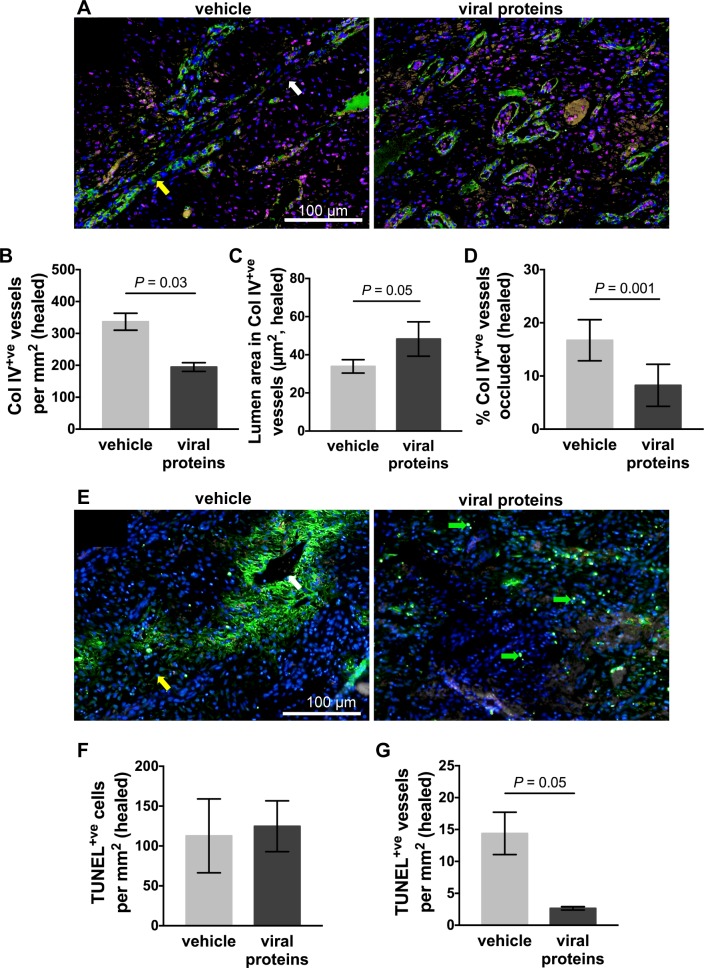
Blood vessel integrity in healed limb wounds of horses following treatment with viral proteins.(A) Representative photos of healed wounds stained with DAPI (blue) and antibodies against blood vessel endothelial cells (CD31: pink) and basal lamina (collagen IV: green). (B) Number of collagen IV+ve blood vessels (C) lumen area in collagen IV+ve blood vessels and (D) percentage of blood vessels occluded in the scar tissue of healed wounds following administration of vehicle or viral proteins. (E) Representative photos of healed wounds stained with DAPI (blue) and by TdT dUTP Nick-End Labelling (TUNEL: green). Green arrows indicate individual dying cells. Yellow and white arrows indicate a healthy and a dying blood vessel, respectively. Number of TUNEL+ve (F) cells (area of single cell < 50 μm2) and (G) blood vessels (area of 3 or more adjacent cells > 150 μm2) in the scar tissue of healed wounds following administration of vehicle or viral proteins. Values represent mean ± SEM, n = 4. P values indicated were determined using a two-tailed ratio paired t-test.